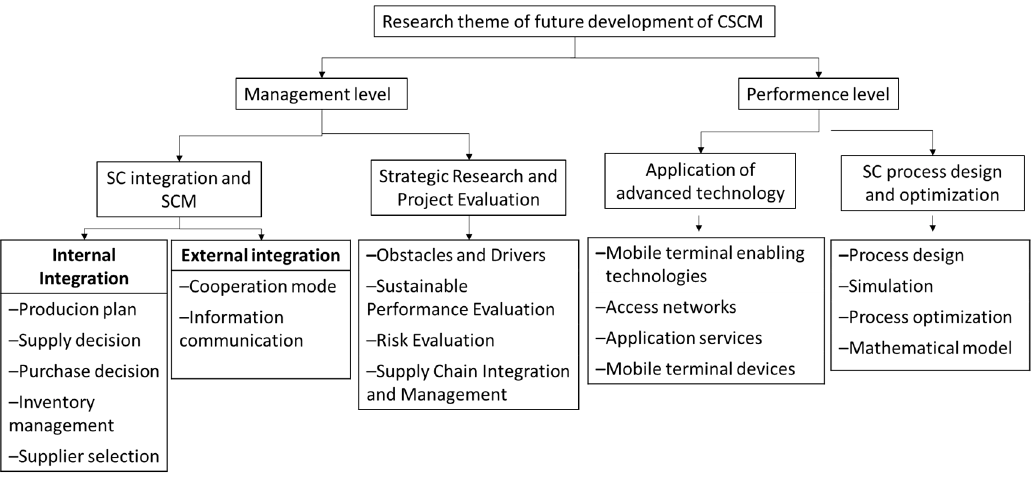
Figure 14. Future development theme direction .